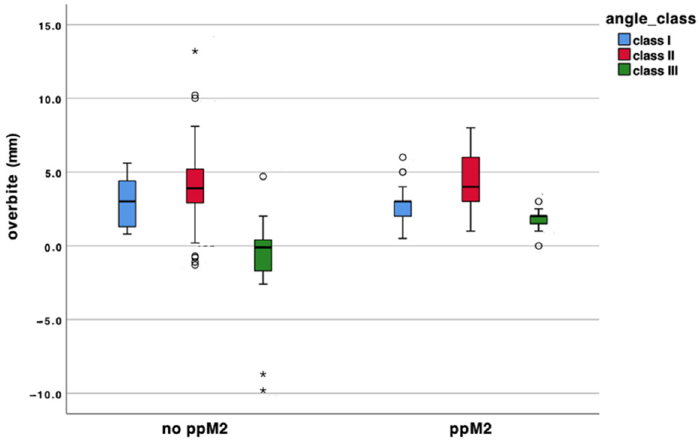
Figure 6. Relationship between overjet and angle-classification in the experimental and control group.